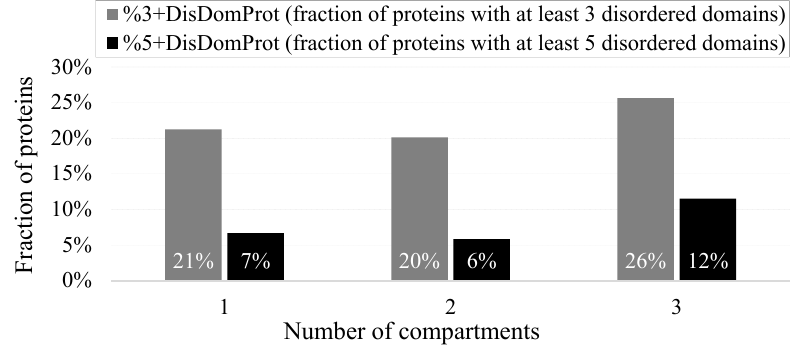
Figure 5. Fraction of proteins with 3 or more (%3+DisDomProt) and 5 or more (%5+DisDomProt) disordered domains for the nuclear proteins from the NUCLEAR ap dataset localized in 1, 2, and 3 intra-nuclear compartments. Disorder was annotated with the consensus of Espritz and IUPred.